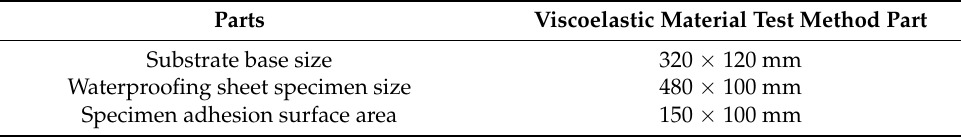
Table 2. The size of the mortar specimen and adhesion area for the viscoelastic strength